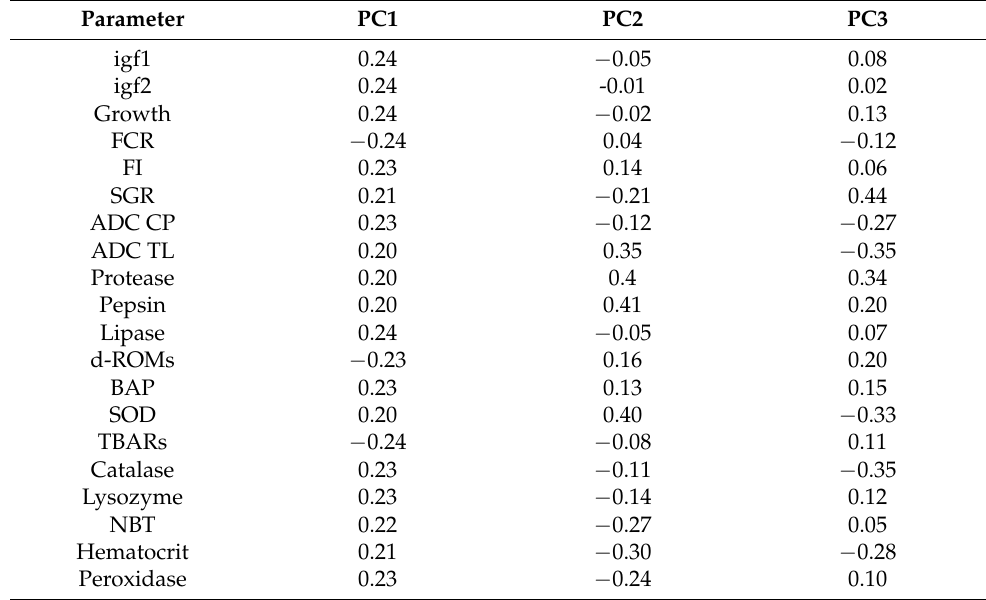
Table 10. Table of loading for the parameters assessed with principal component analysis. PC1 and PC2 explained the total variation as displayed.